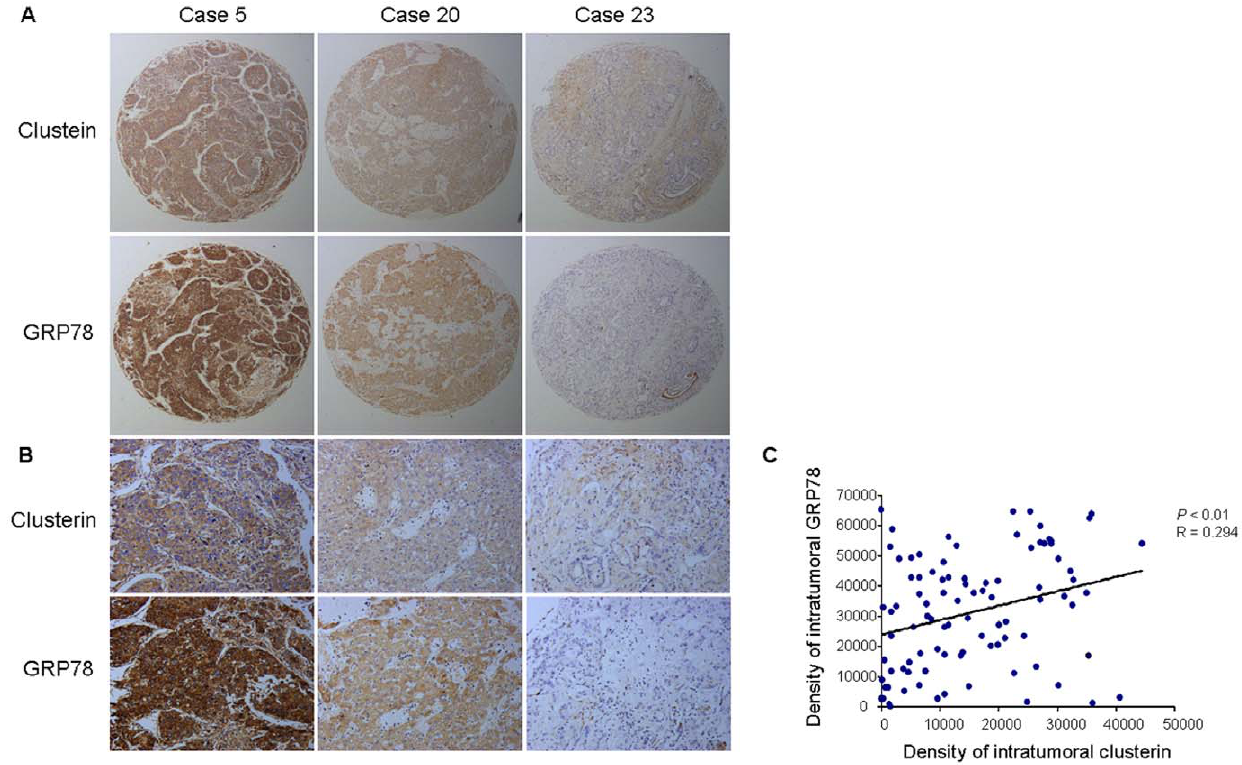
Figure 6. There was a correlation between the levels of CLU and GRP78 in clinical HCC specimens. (A–B) Representative immunostaining for CLU and GRP78 is shown for three patient samples (A: 6 50; B: 6 200). (C) Positive correlation between CLU expression and GRP78 level was examined in tumor tissues derived from 96 patients (r=0.294, P , 0.01).